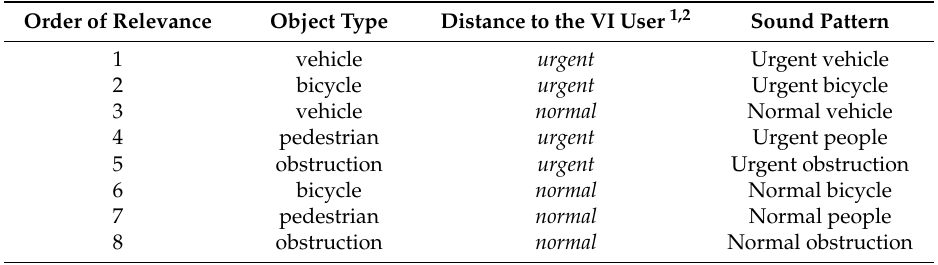
Figure 8. Warning message prioritization based on the object semantic interpretation. Table 2. The set of acoustic warning messages.